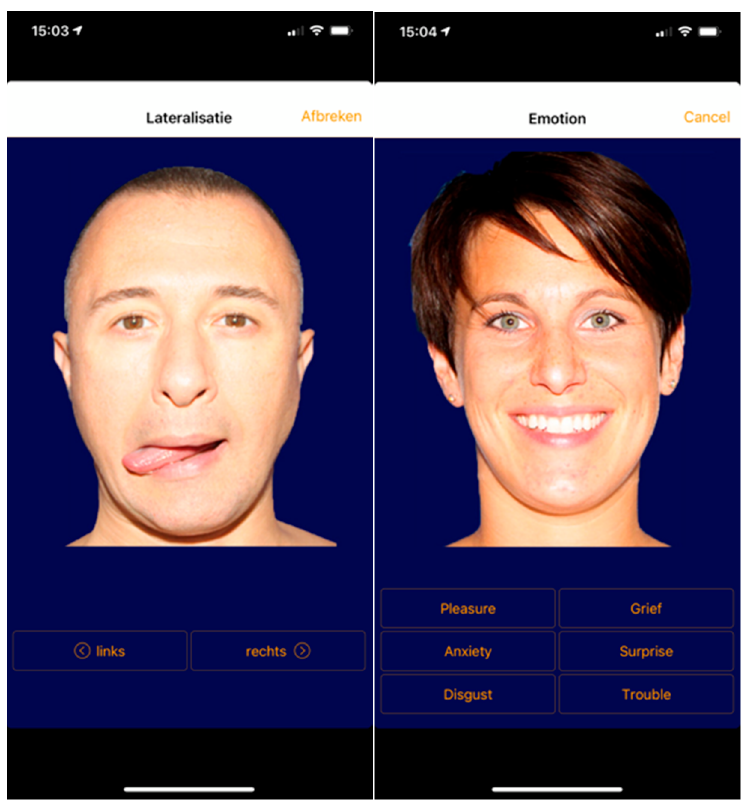
Figure 7. Example of the laterality test ( left image ) and basic emotion test training ( right image ) on a mobile telephone, which may be converted in intervention parameters easily.